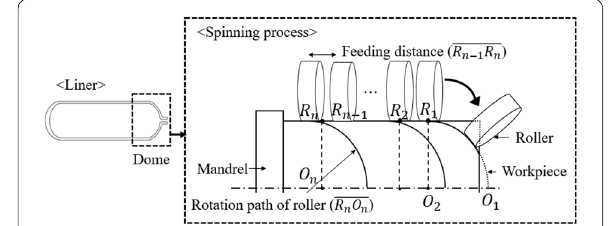
Figure 6 Spinning process to manufacture the dome part of